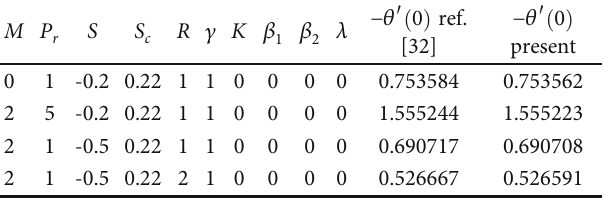
Table 3: Values of local Nusselt number in comparison between current study and previous study ref. [32].